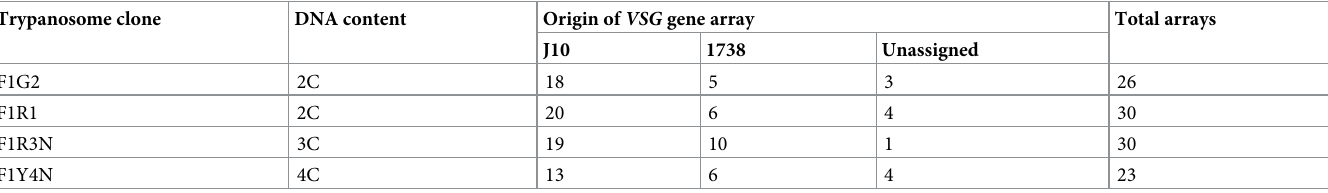
Table 2. Comparison of numbers of VSG gene arrays inherited by hybrid progeny from parents J10 and 1738. Trypanosome clone DNA